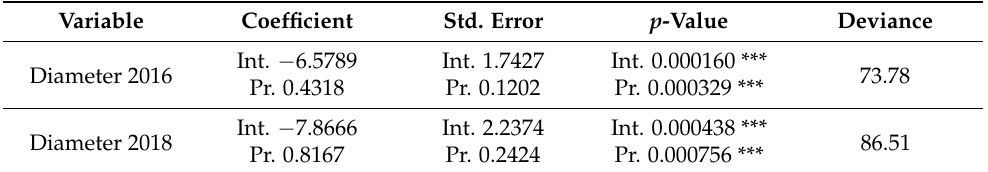
Table 4. GLM binomial models results for reproductive maturation in Tetraclinis articulata . Int.: intercept, Pr.: predictor. Significance codes: *** < 0.001.